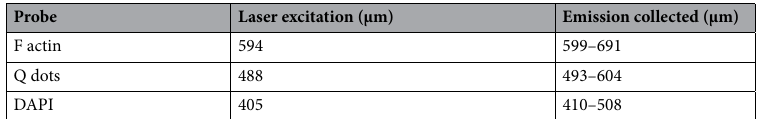
Table 3. Excitation wavelengths of lasers used for laser confocal microscopy detection of